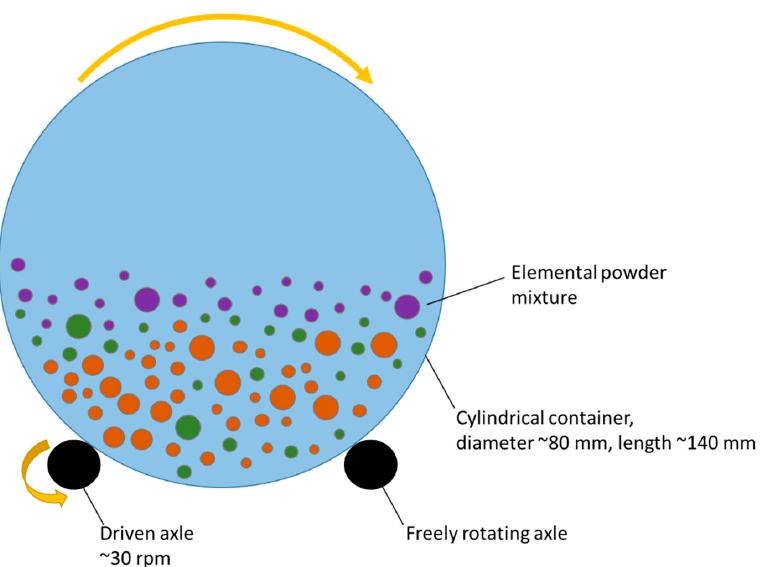
Figure A1. Schematic representation of the roller mixer used for mixing of elemental powder.